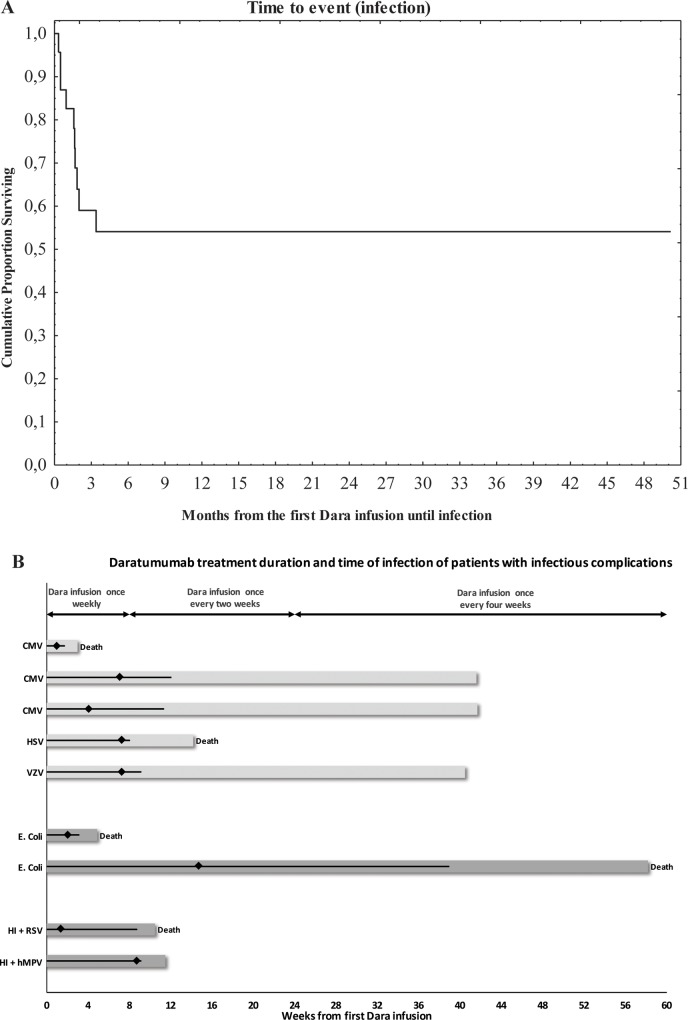
Timeline of dara treatment and occurrence of infectious complications of all patients.Dara treatment was given according to protocol, as indicated in the experimental procedures and study design. Nine of 23 patients suffered from bacterial or viral infections, the median time to event are presented in Fig 2A. The unique timeline of Dara treatment is depicted for each of the nine patients with infectious complications, as shown in Fig 2B, with the time of total Dara treatment as a black line, and the occurrence of infection with a black rhomb. Dark grey bars indicate bacterial infections, and light grey bars indicate viral complications. End of follow-up due to death is noted in the figure. The insert shows the median and range of weeks of Daratumumab treatment and follow-up. CMV = cytomegalovirus, HI = H. Influenza, RSV = respiratory syncytial virus, hMPV = human metapneumovirus, HSV = herpes simplex virus, VZV = varicella zoster virus.